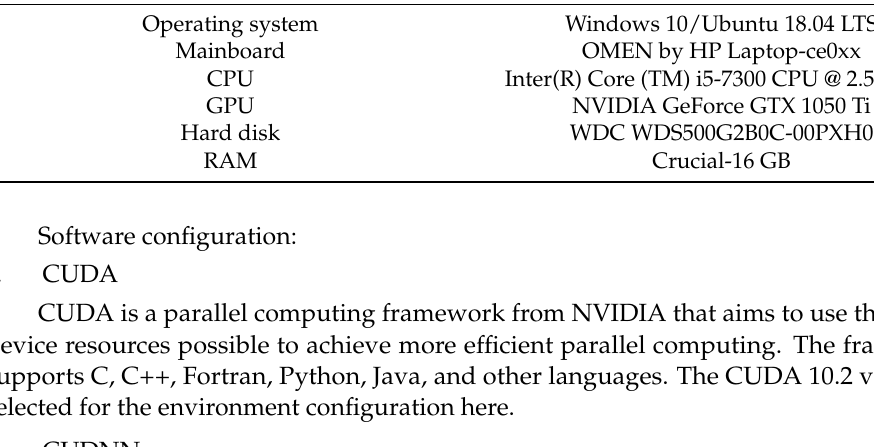
Table 1. The hardware configuration of the computer to perform YOLOv5. Hardware